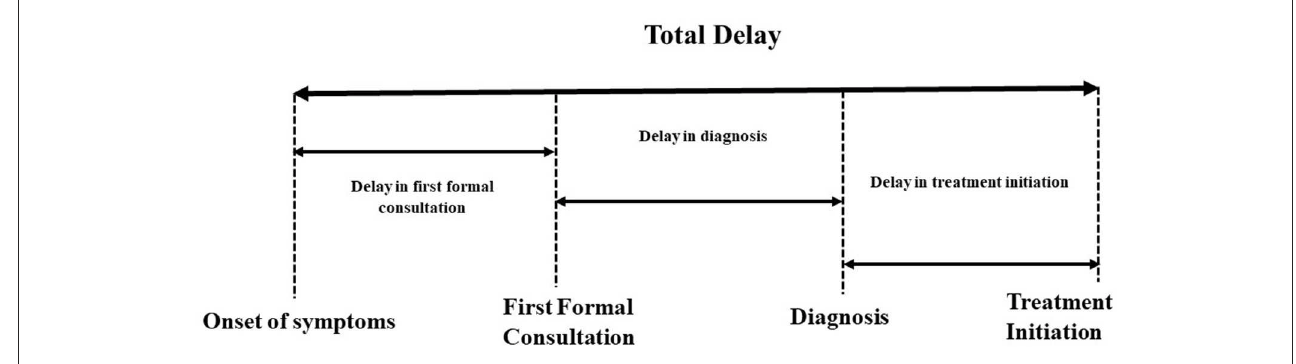
FIGURE1 Delays in the various phases of TB care